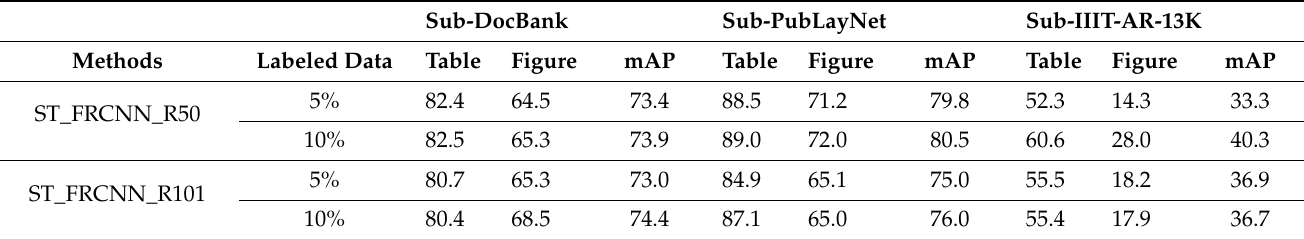
Table 14. The table represents the mAP@(0.5:0.95) of sub-DocBank, sub-IIIT-AR-13K and sub- PubLayNet validation datasets on a sub-DocBank trained